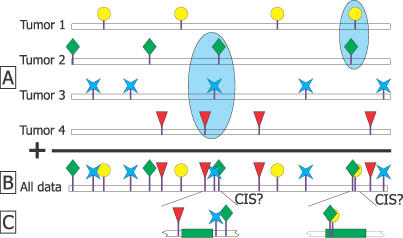
Schematic View of Insertion Data(A) Schematic view of the mapped data of four tumors. Significance is determined by the number of tumors which contain insertions in a particular region. The geometric symbols represent the insertions and are given a different shape for each tumor. The blue regions indicate possible CISs.(B) When considering a broad region, the number of insertions one would expect to have occurred by chance is higher, and hence the regions need to be hit in more independent tumors than for narrow regions before significance is reached.(C) Genes (indicated by the green bars) may be affected from various loci around or within the gene, and there does not exist one distance over which viral inserts act on their targets.